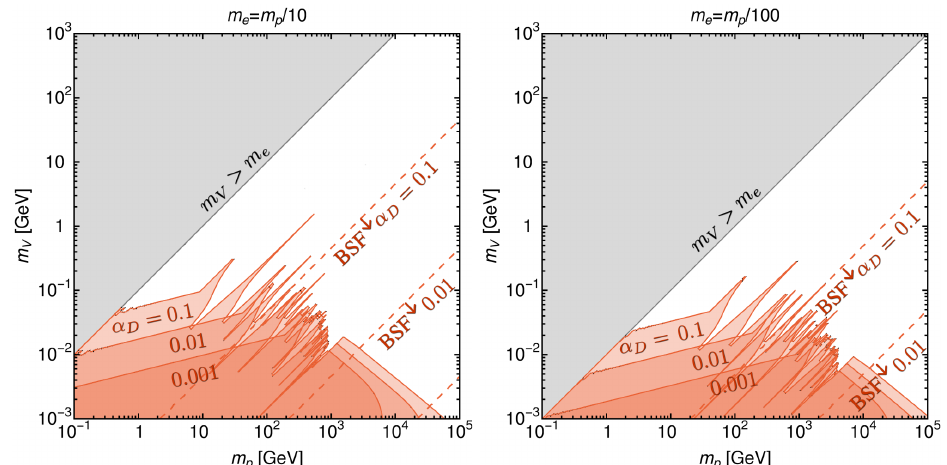
Figure 5: Parameter space in which dark electrons thermalise with the dark pro- tons, for two examples of dark electron masses. We take ρ ≈ 20 km / s. Efficient thermalisation requires m v rel highly constrained from other measurements, cf. Fig.